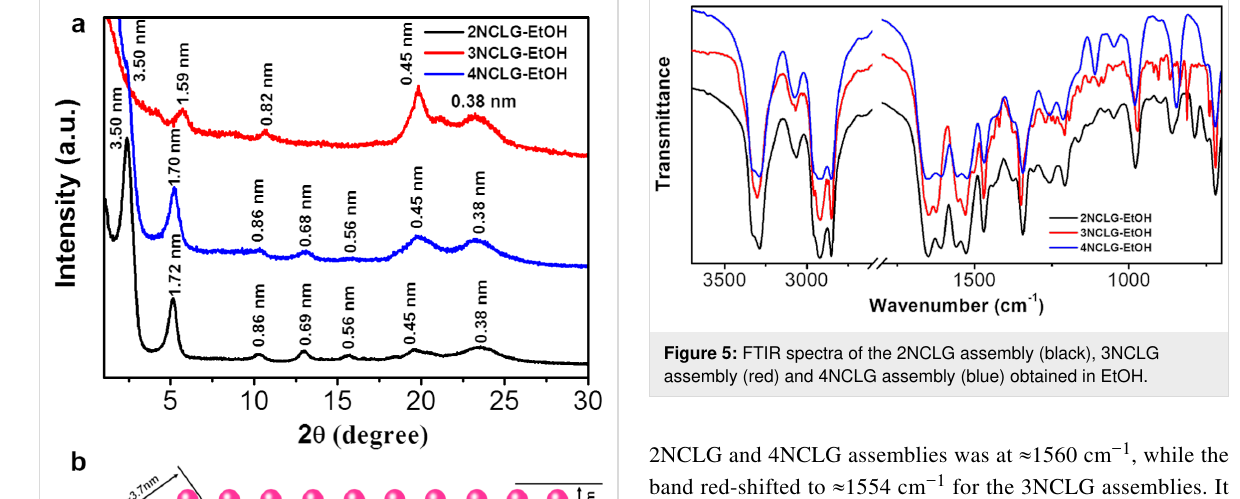
2NCLG and 4NCLG assemblies was at ≈ 1560 cm − 1 , while the band red-shifted to ≈ 1554 cm − 1 for the 3NCLG assemblies. It also indicated that the hydrogen bonding between 3NCLG was weaker than the other two compounds. In addition, the absorp- tion bands at ≈ 1520–1530 cm − 1 and ≈ 1340–1350 cm − 1 could be ascribed to the antisymmetric and symmetric stretching vibra- tion of the nitro group, respectively. The absorption bands at ≈ 970–980 cm − 1 were assigned to trans -vinylene C–H out-of- plane deformations and the ≈ 779–785 cm − 1 absorption bands were attributed to cis -vinylenene C–H out-of-plane